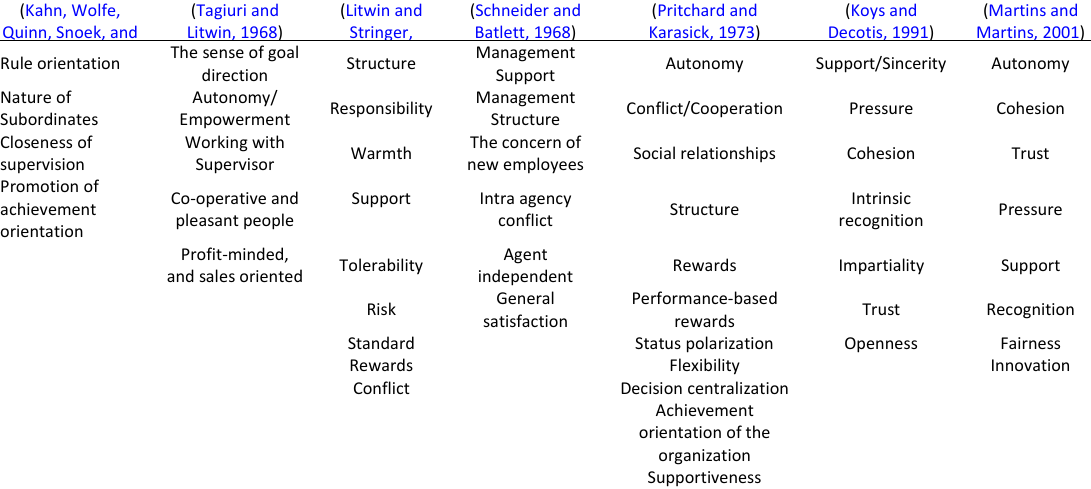
Table 1: Summary of Major Contributors to the Dimensions of Organizational Climate (Authors’ Construct, 2018)